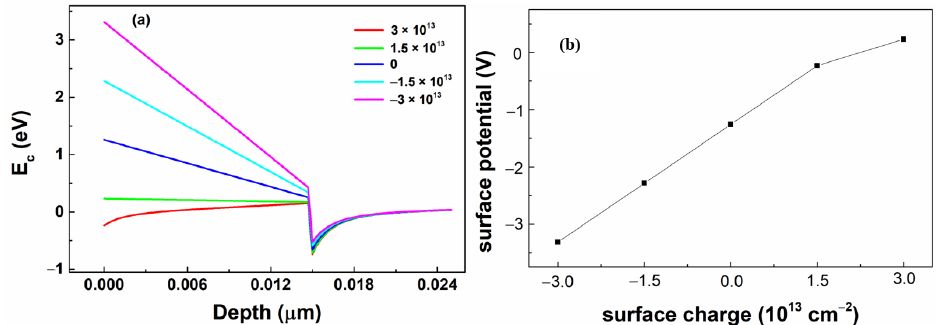
Figure 4. ( a ) The conduction band diagram and ( b ) surface potential of the HEMT under the gate region with different surface charge density.